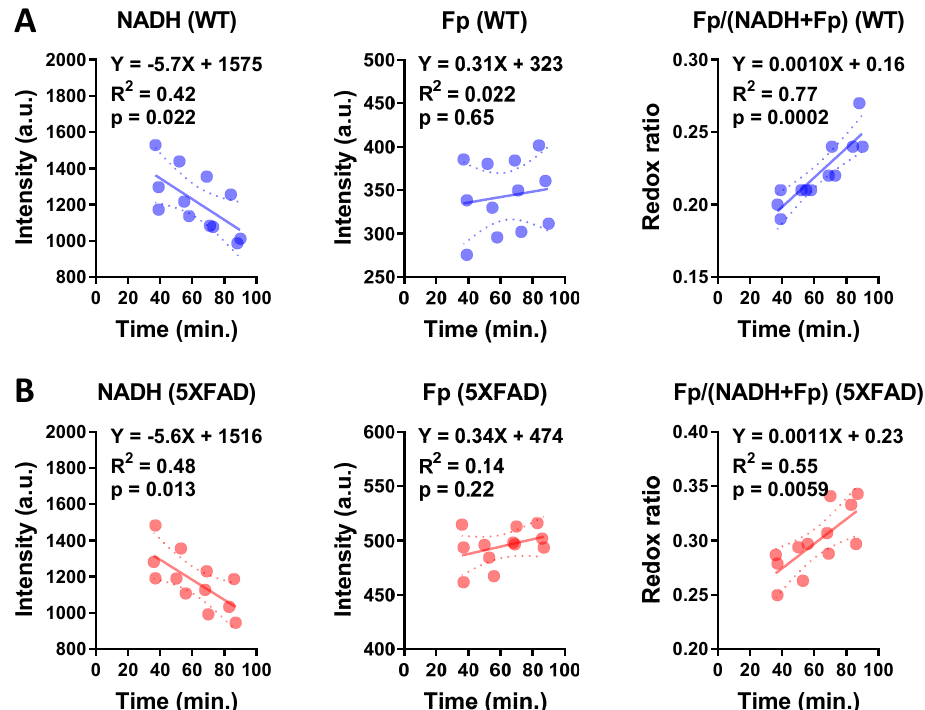
Figure 3. The typical redox changes in cultured hippocampal sections of 6.5-month-old WT ( A ) and 5XFAD mice ( B ). Each dot represents one hippocampal section from an individual mouse and each section was imaged at four time